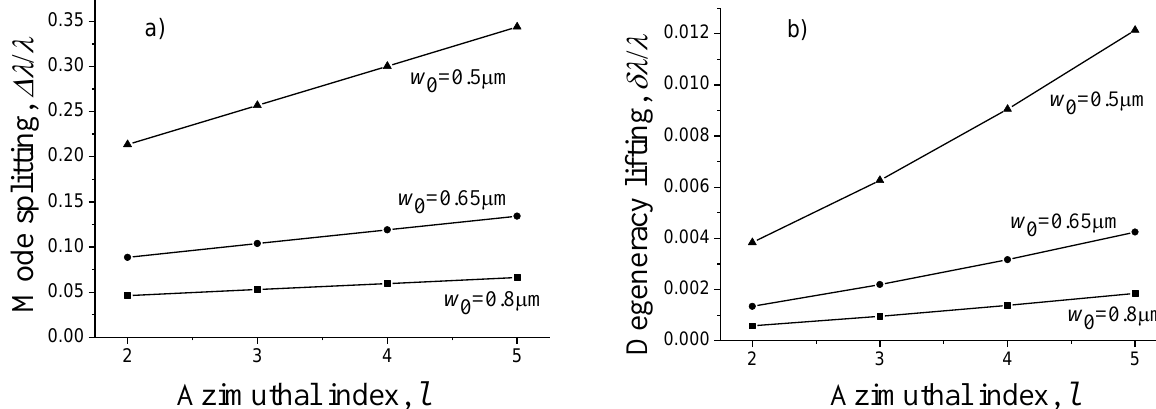
Figure 10. Dependence of the mode splitting ( a ) and degeneracy lifting ( b ) on the azimuthal index. p = 0, n 0 = 1.5 .